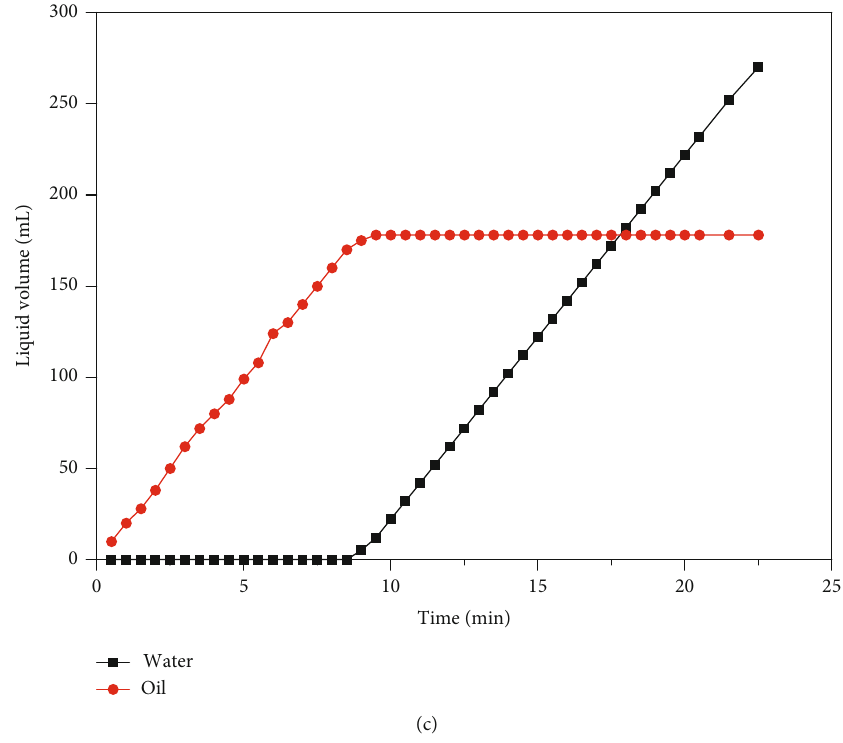
Figure 23: Oil/water production variation curves under connection type II (di ff erent production rates with (a) 1 mL/min, (b) 10 mL/min, and (c) 20